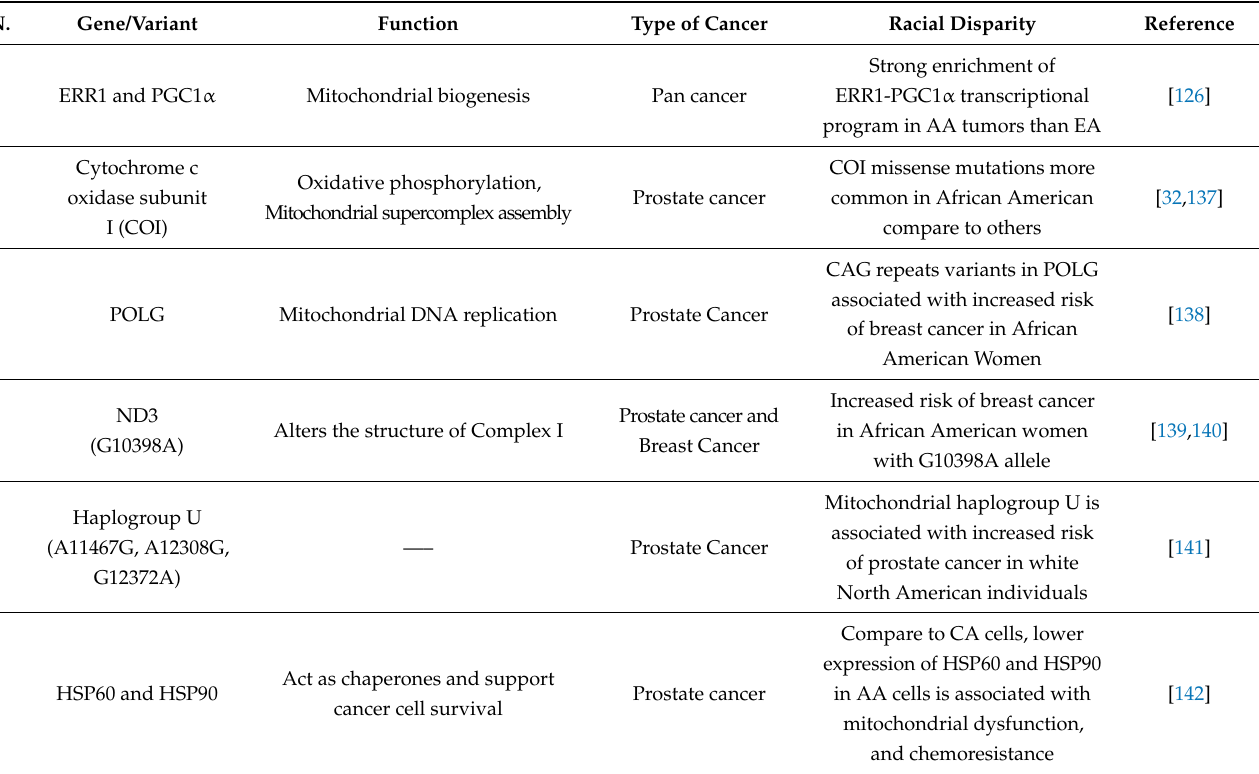
Table 1. Mitochondrial gene variants and their association with racial disparity in prostate cancer AA—African American, EA—European American, CA—Caucasian